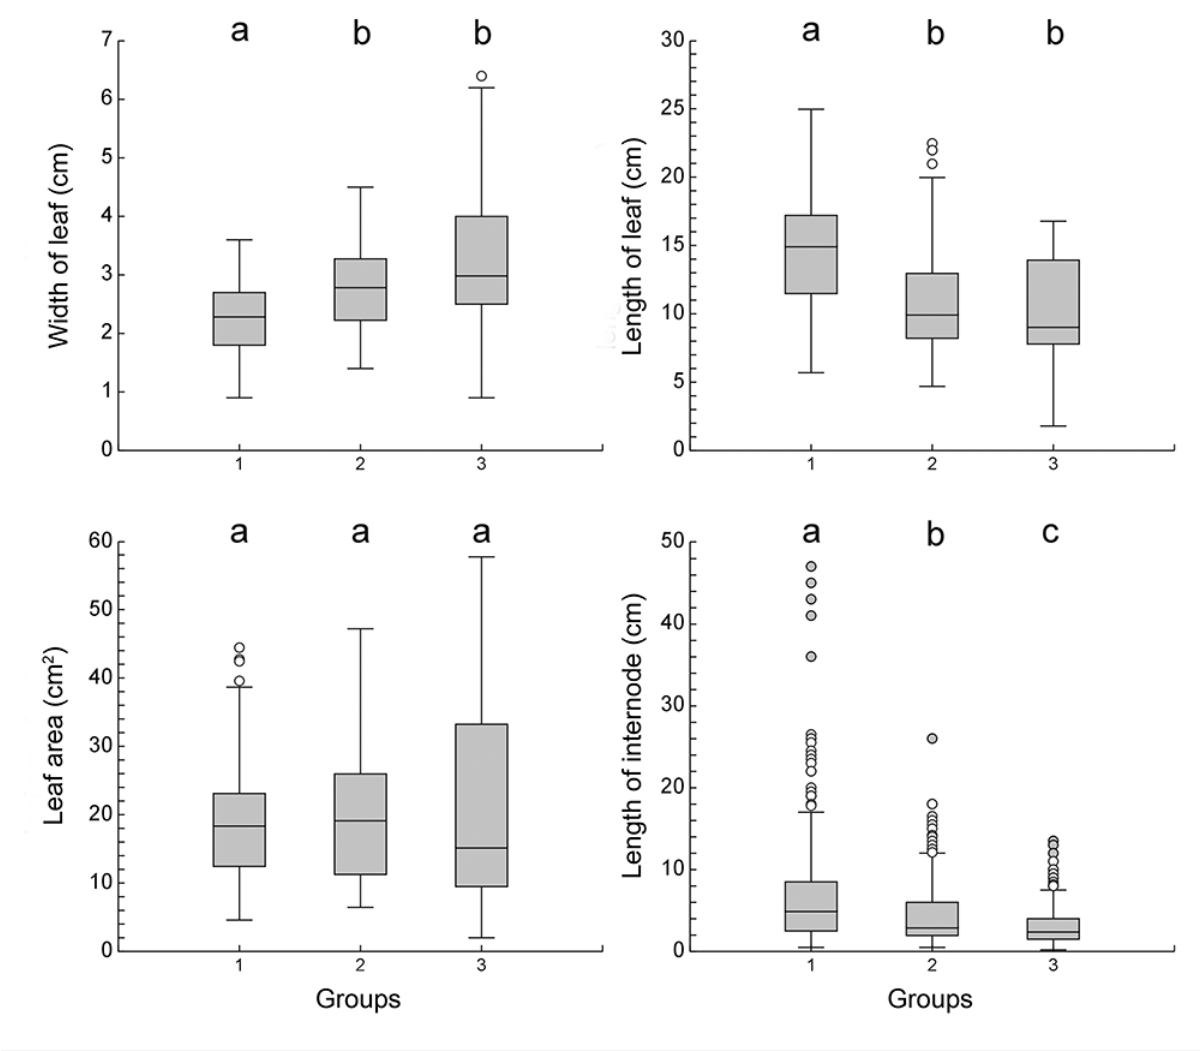
Figure 5 Differences in morphological parameters of Potamogeton praelongus in particular groups. Letters a, b, and c characterize group differences based on multiple comparison tests (Kruskal–Wallis Z test with Bonferroni correction). Grouping of study sites follows that shown in Table